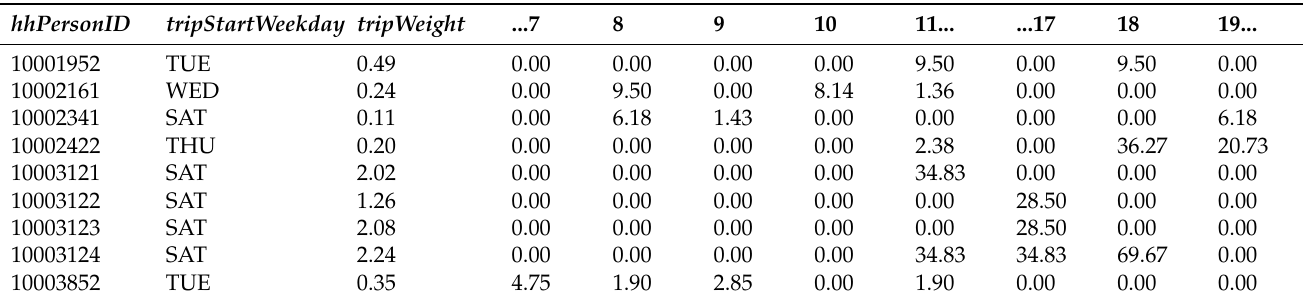
Table A3. Exemplary output (first 9 observations) of daily travel diaries as input for VencoPy. hhPersonID